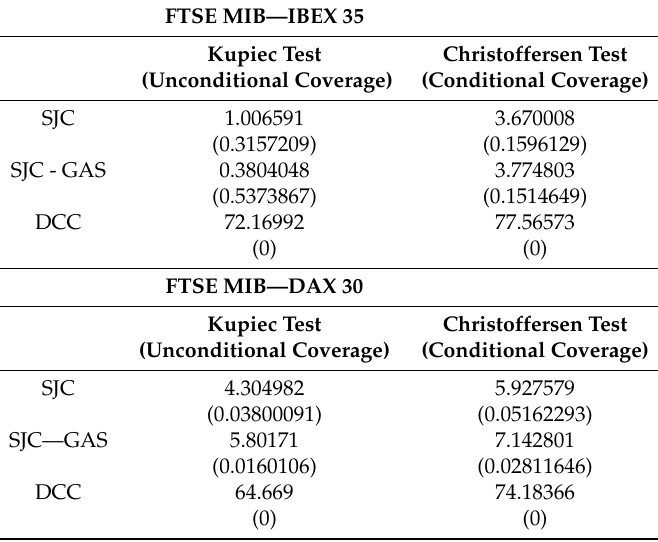
Table 6. Test statistic (t.s.) and, in brackets, p -values for Kupiec test and Christoffersen test, considering 1%–VaR on an equally weighted